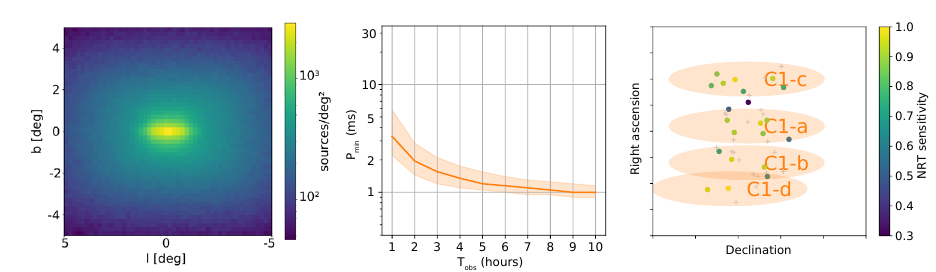
Figure 1. Left: Positions of MSPs in our simulation. Middle: Minimal detectable MSP period as a function of GBT observing time for one promising candidate. The line assumes a radio spectral index α = 1 . 9 and the shaded area considers 2 . 43 < α < 1 . 37. Right: NRT observation strategy. The − − − orange ellipses show the NRT beam. Colored dots indicate the positions of the most interesting MSP candidates and the sensitivity of the telescope at this position. Gray crosses represent other